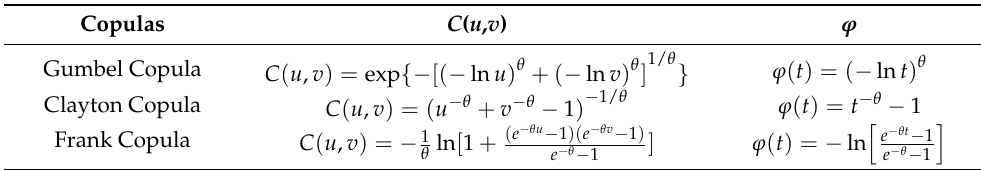
Table 1. Archimedean copulas and generators ϕ